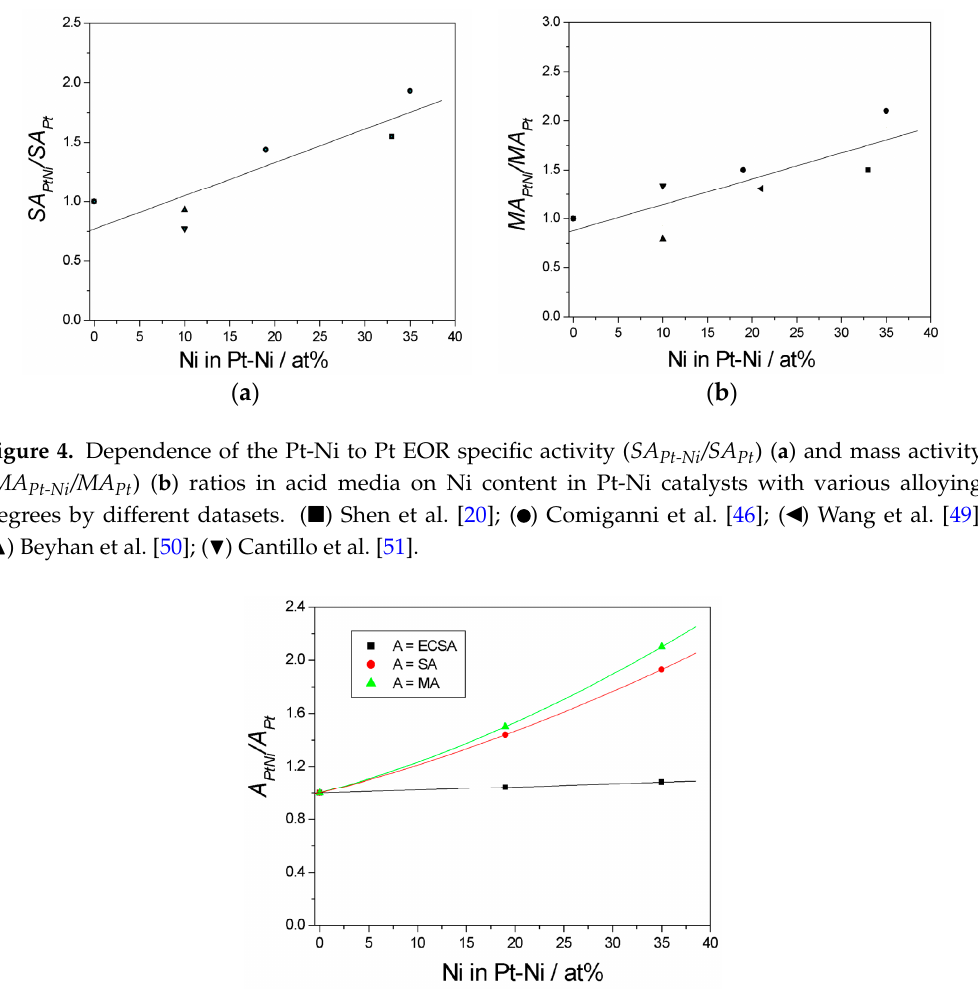
Figure 5. Dependence of the ( A Pt-Ni /A Pt ) ratios (A = ECSA, SA and MA) of non-alloyed Pt-Ni/C on Ni